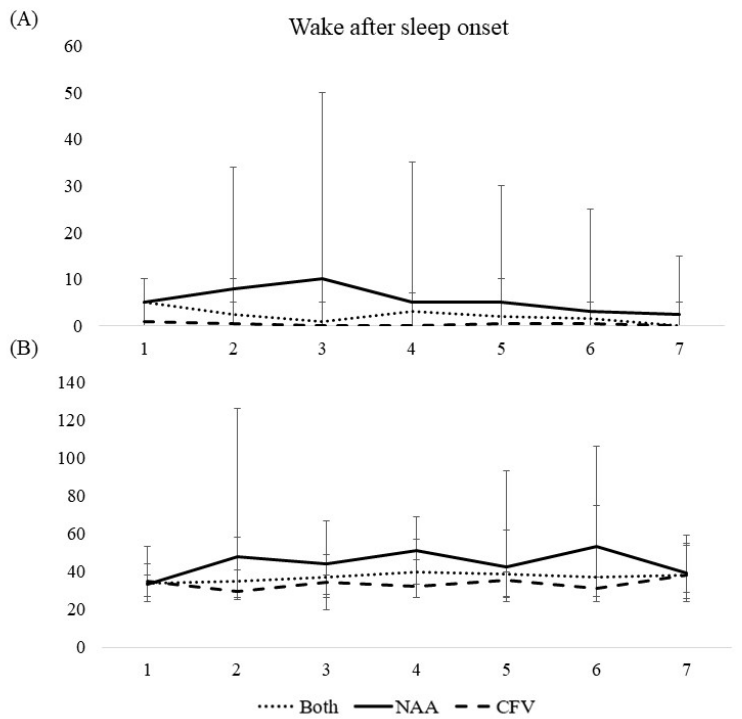
Figure 2. Median scores of wake after sleep onset during a 7-day workweek among pilots in the Norwegian Air Ambulance (NAA; n = 25), Christophorus Flugrettungverein (CFV; n = 22), and both groups collapsed, measured by ( A ) sleep diary and ( B ) actigraphy. Error bars represent quartiles.